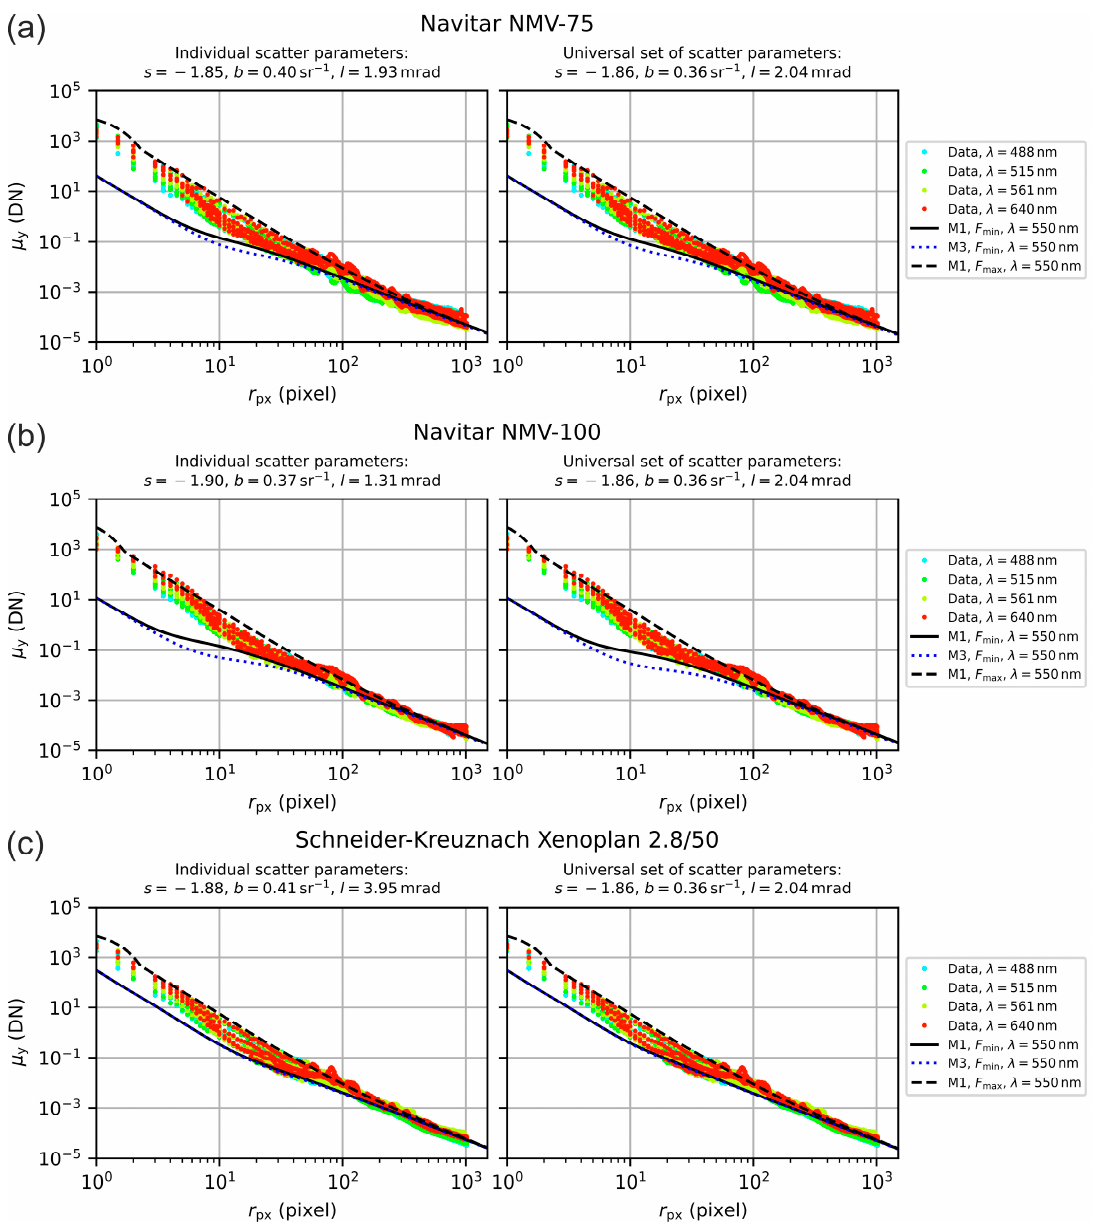
Figure 19. Comparison of measured irradiance profiles and predictions of the theoretical model M1. Calculations were performed both using the individual scatter parameters of the lens (graphs on the left hand side) and the generic set of scatter parameters (graphs on the right hand side). Lenses: ( a ) Navitar NMV-75, ( b ) Navitar NMV-100 and ( c ) Schneider-Kreuznach Xenoplan 2.8/50.